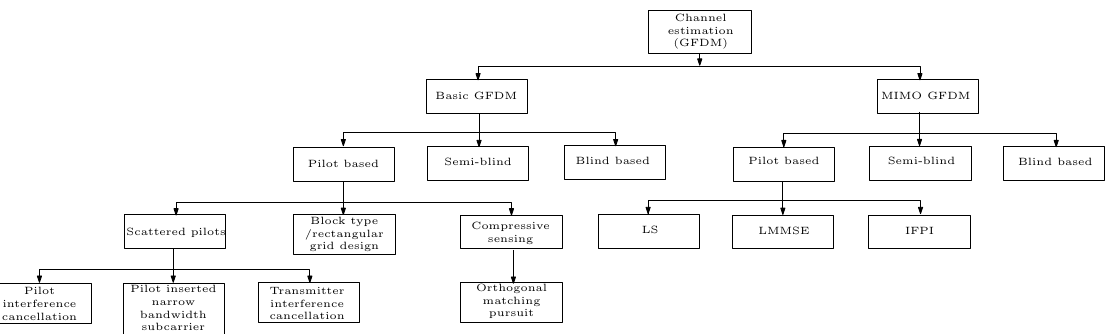
Figure 14. CE schemes for conventional